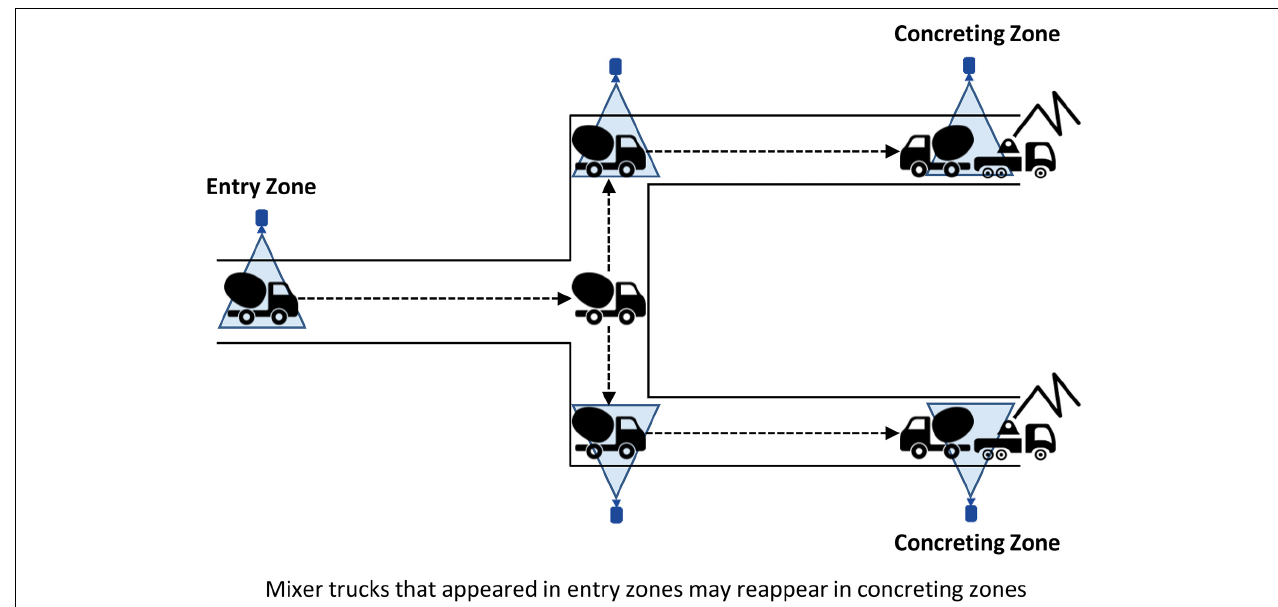
FIGURE 7 | Spatio-temporal cues and site-layout information for multi-target multi-camera